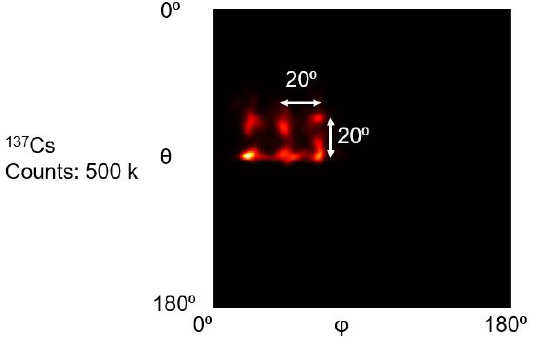
Figure 14. The reconstructed images of experimental 2 × 3 137 Cs point source array.